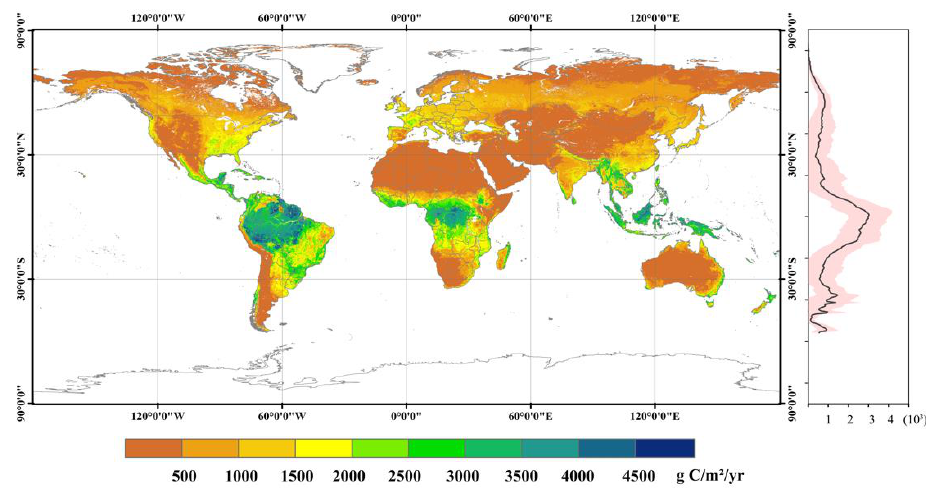
Figure 7. Spatial pattern of global GPP estimated by the NI-LUE model during 2001-2018.